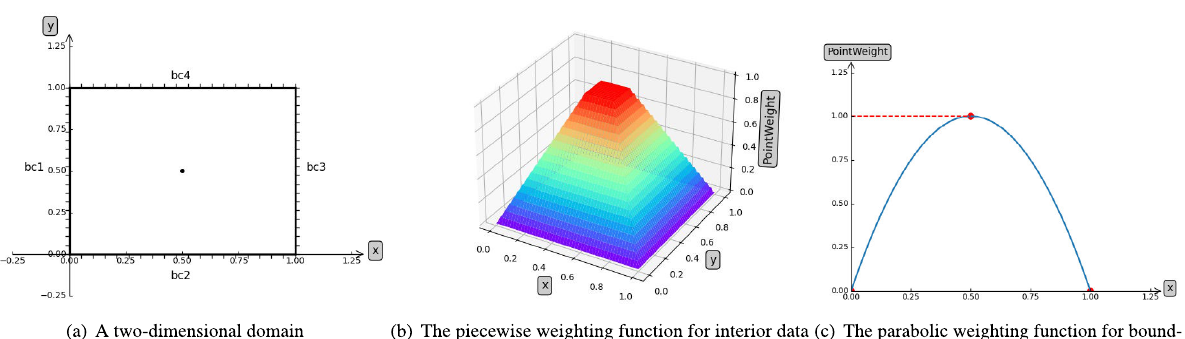
Figure 1. The weighting mechanism used in the proposed DFS-Net.